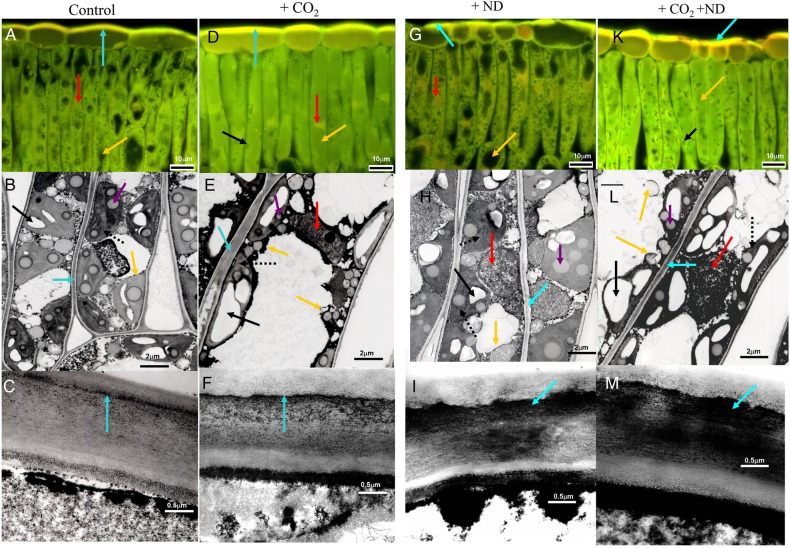
Structural effects of +CO2 (D–F), +ND (G–I) and +CO2 + ND (K–M) versus control (A–C) in the leaf blade cells of beech. Under +CO2, cells were enlarged (E versus B), cell walls thickened—primarily by pectin inlays within the outer wall layers (cyan arrows in D–F versus A, C), nuclear chromatin condensed (red arrows in D, E versus A, H) and vacuoles enlarged (yellow arrows in D, E versus A, B). The latter organelles also showed an irregular contour, as a consequence of plastoglobule extrusion and cytoplasm invagination, and they contained more phenolics. Moreover, chloroplasts showed characteristic changes including a lower frequency, a fuzzy grana and thylacoid structure and larger starch grains (dashed and black arrows in E versus B). Under +ND (G–I), a mostly intact cell structure was observed. As a tendency, electron-translucent plastoglobuli were enlarged (violet arrow H versus B), nuclei (red arrow) somewhat condensed and the size and frequency of starch grains (black arrow) and PC droplets slightly increased. The epidermal cell walls showed irregular thickening (G, I versus A, C). The +CO2 + ND treatment (K–M) triggered changes similar to those observed in response to +CO2. Staining with Coriphosphine for pectins (bright yellow), viewed at 450–490 nm excitation (A, D, G and K), TEM of palisade cells (B, E, H and L) and upper epidermal outer cell wall (C, F, I and M).